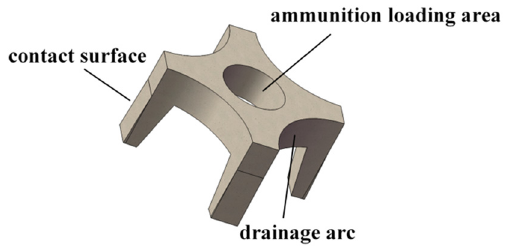
Figure 2: The model of quadrupole armature.